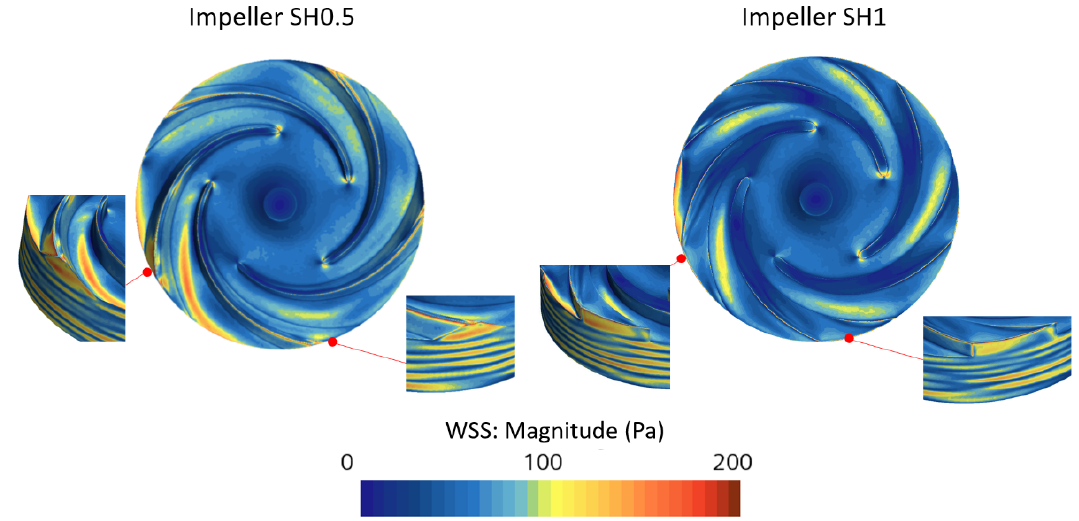
Figure 12. WSS magnitude for the two pumps.